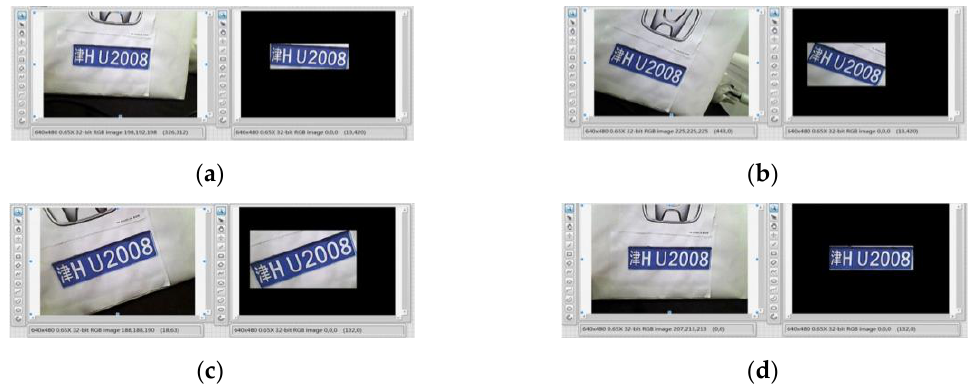
Figure 17. License plate positioning results: ( a ) Position 1, ( b ) Position 2, ( c ) Position 3, and ( d ) Position 4.